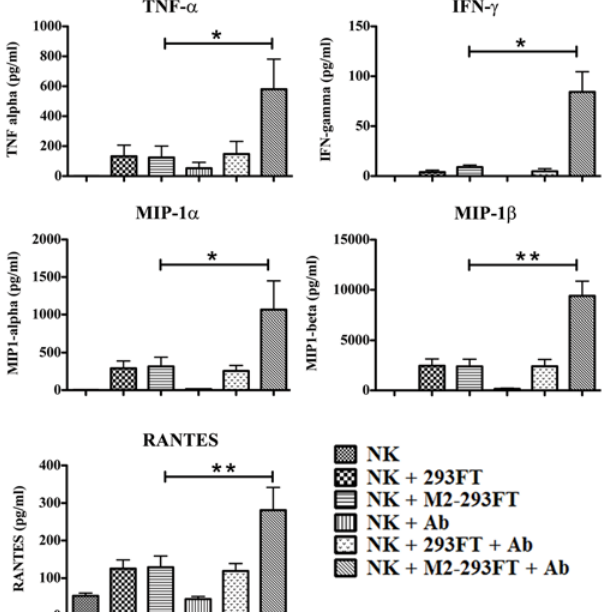
Fig 3. Cytokine release by freshly isolated NK cells in the presence of Ab1-10 mAb. Freshly isolated NK cells were either left untreated or co-cultured with both 293FT cells and M2-293FT cells in the presence and absence of Ab1-10 mAb (Ab). Culture supernatants were harvested and tested for the secretion of human cytokines and chemokines using flow-cytometric bead analysis. The values on the y-axis correspond to the concentrations of TNF- α , IFN- γ , MIP-1 α , MIP-1 β and RANTES in pg/ml. Graph bars represent the average ± SEM. Data shown are from five independent experiments with freshly isolated NK cells from five donors ( * P < 0.05, ** P <